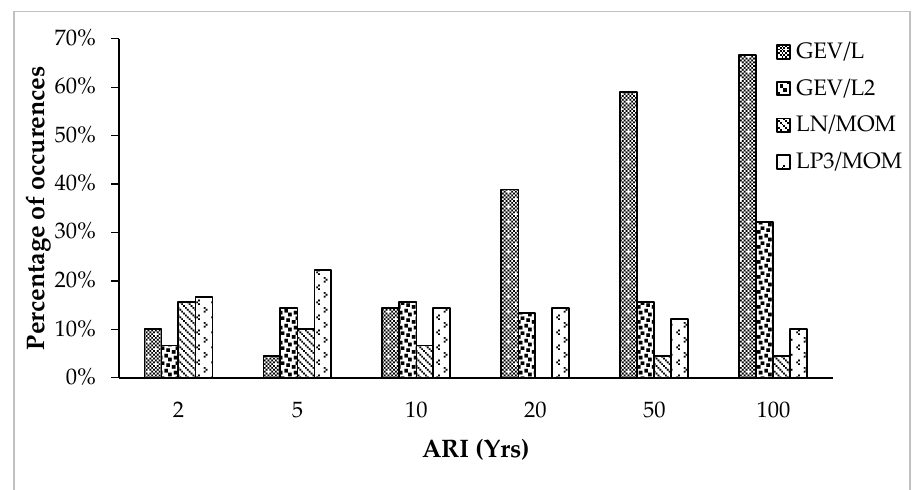
Figure 6. Comparison of the performance of four selected models in analyzing three selected series (7-day, 15-day, and 30-day) .